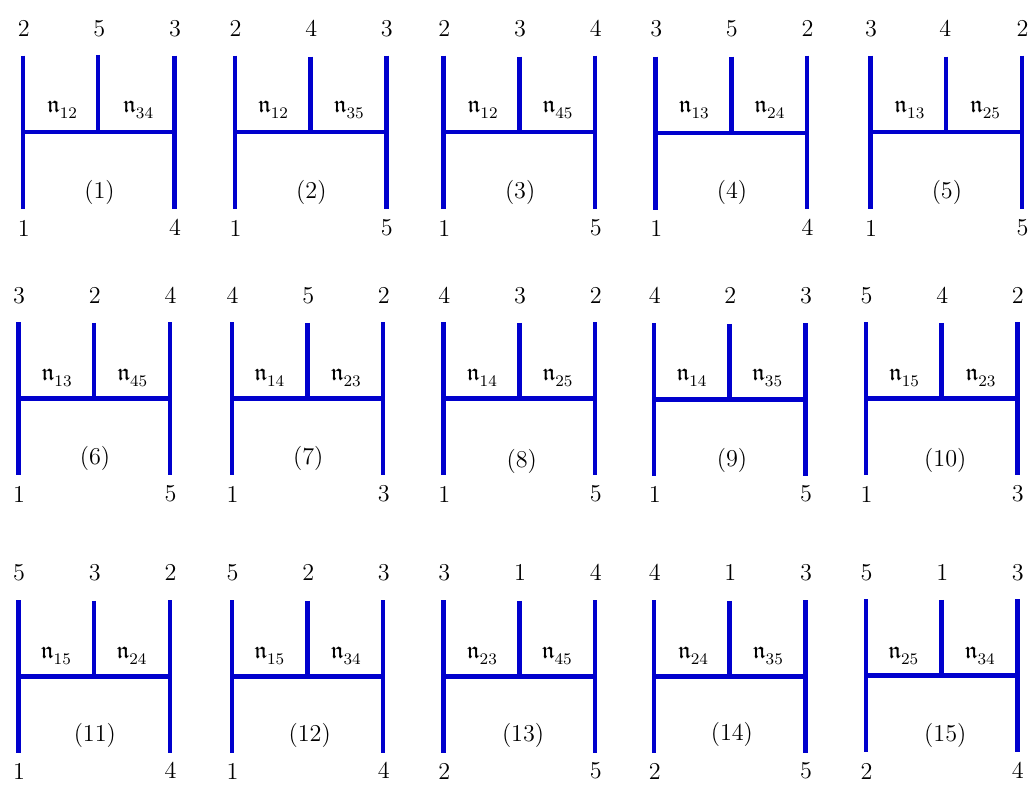
Figure 1 . Independent structures of the color-dressed five-point scattering amplitudes of KK gauge bosons or KK gravitons at tree level, where the numbers { 1 , · · · , 5 } denote the KK indices of the external KK states, { 1 , · · · , 5 }∼ { n